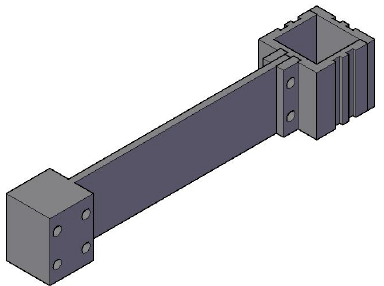
Figure 1. Concept map of the tuned mass damper (TMD) device.